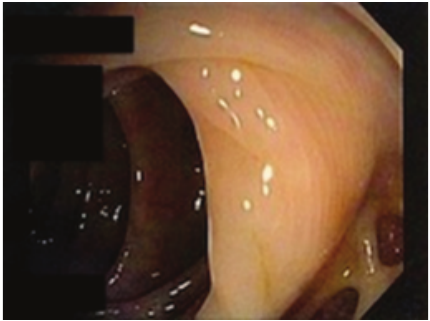
Figure 4: Colonoscopic image of the patient’s diverticular disease. No active bleeding was noted during the